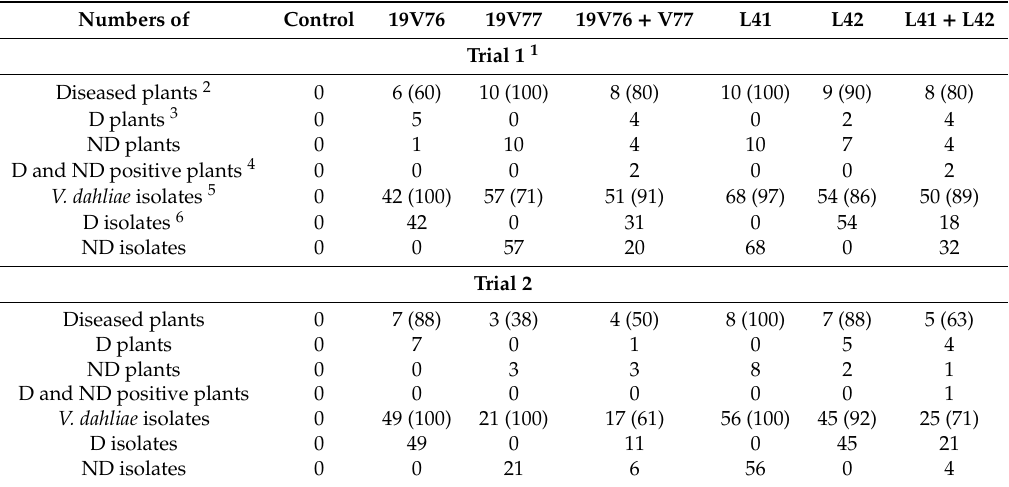
Table 2. Number of diseased, D and ND plants recorded in the two pot trials inoculated with the tested V. dahliae isolates, and the number of D and ND isolates recovered upon termination (four weeks after inoculation) of the pathogenicity assays.